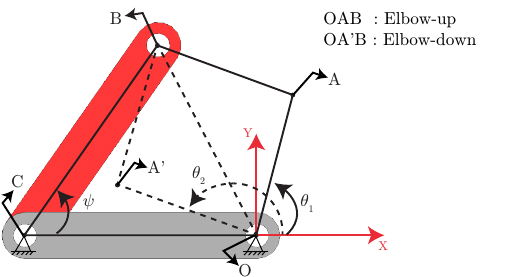
Figure 8. The elbow-up OAB and elbow-down OA’B are two possible constructions in which the four-bar linkage can be assembled for one ψ angle of the output link